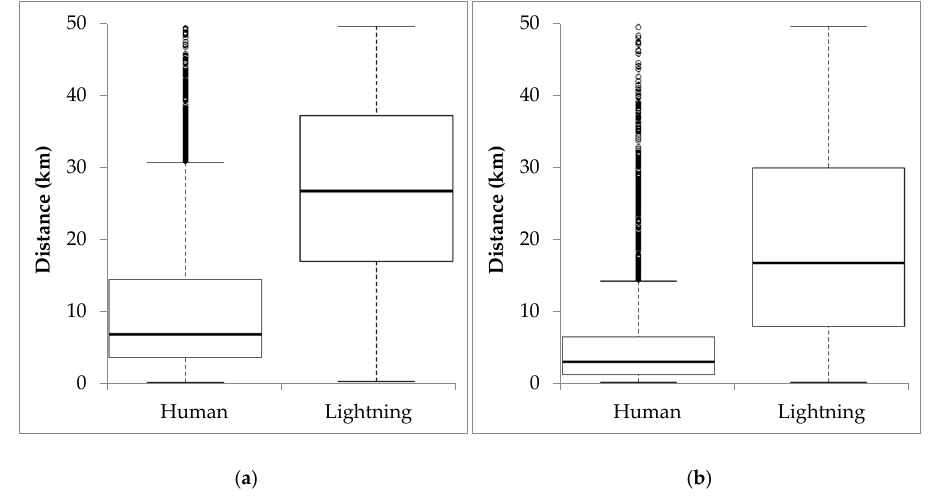
Figure 3. General relationship between ignition cause and human proximity in interior Alaska as determined by Kruskal–Wallis tests for 1990–2016: Median distance of ignitions from ( a ) nearest settlement and ( b ) nearest highway. The boxplots show median values (thick line) with the first and third quartile forming the lower and upper boundary of the box, respectively; the dashed lines indicate 1.5 times the upper or lower quartile and the circles represent outliers.